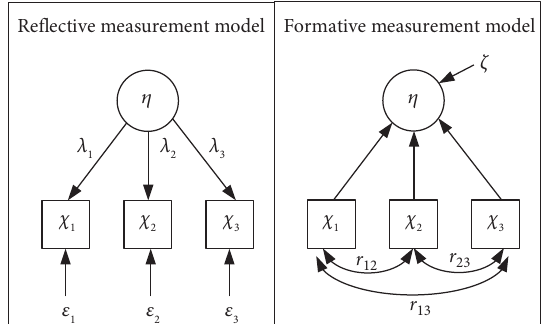
Figure 4: Illustration of reflective and formative measurement